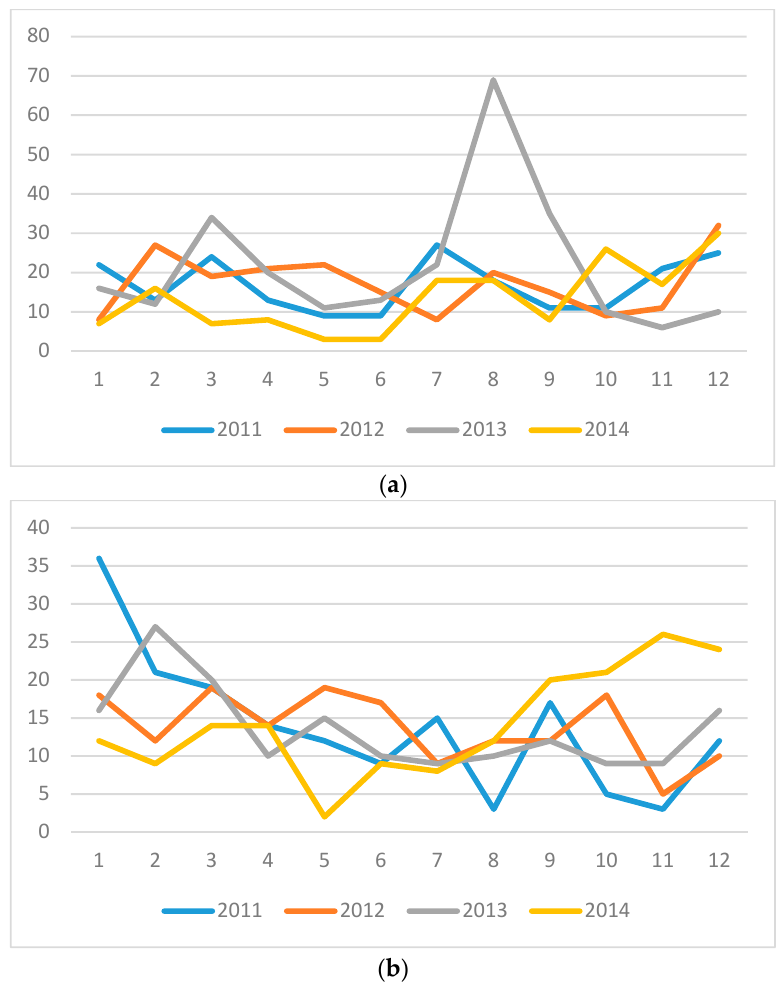
Figure 1. ( a ) Monthly variation of cases of diarrhea, stratified by year. X-axis: months of the year; y-axis: absolute number of cases. ( b ) Monthly variation of cases of respiratory diseases, stratified by year. X-axis: months of the year; y-axis: absolute number of cases.